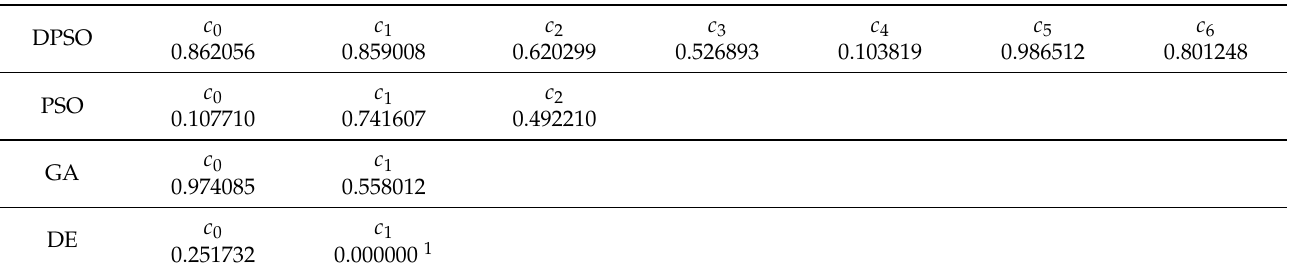
Table A1. Global best self-tuning parameters for 7